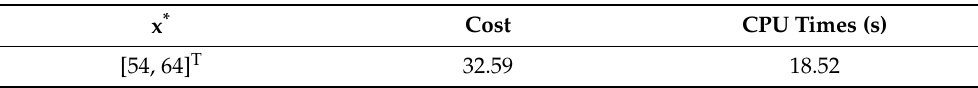
Figure 7. Comparison of sliding ratio between original ALO and RALO. * x Table 1. The quasi-optimal design , cost and the CPU times of the best run in small example.